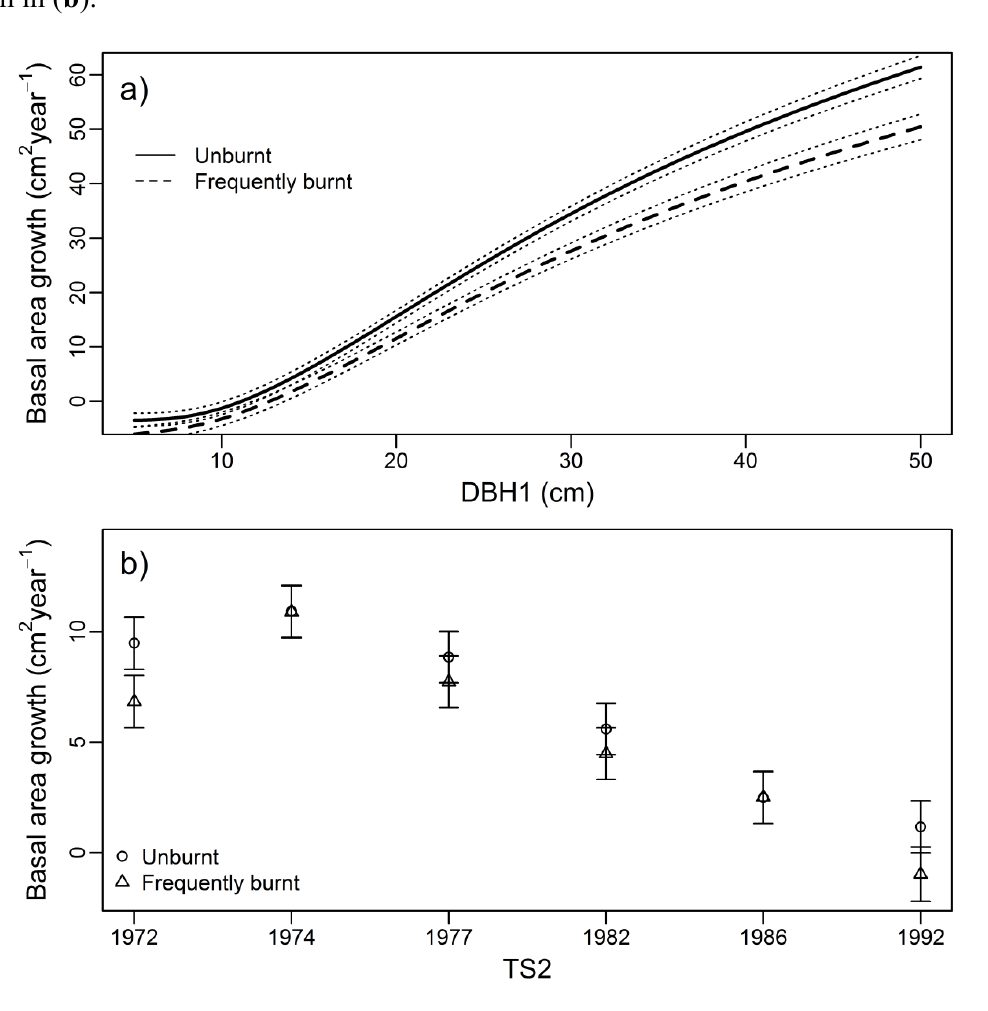
Figure 4. Model predictions of annual change in basal area of overstorey species between measurement periods (cm 2 year −1 ) in response to: ( a ) burning treatment and DBH at the first survey (DBH1); and ( b ) timing of the second survey (TS2) and burning treatment. Dotted lines in ( a ) show the 95% confidence interval. Error bars in ( b ) show 95% confidence intervals. Predictions held TS2 constant at 1992 in ( a ) and DBH1 constant at 12 cm in ( b